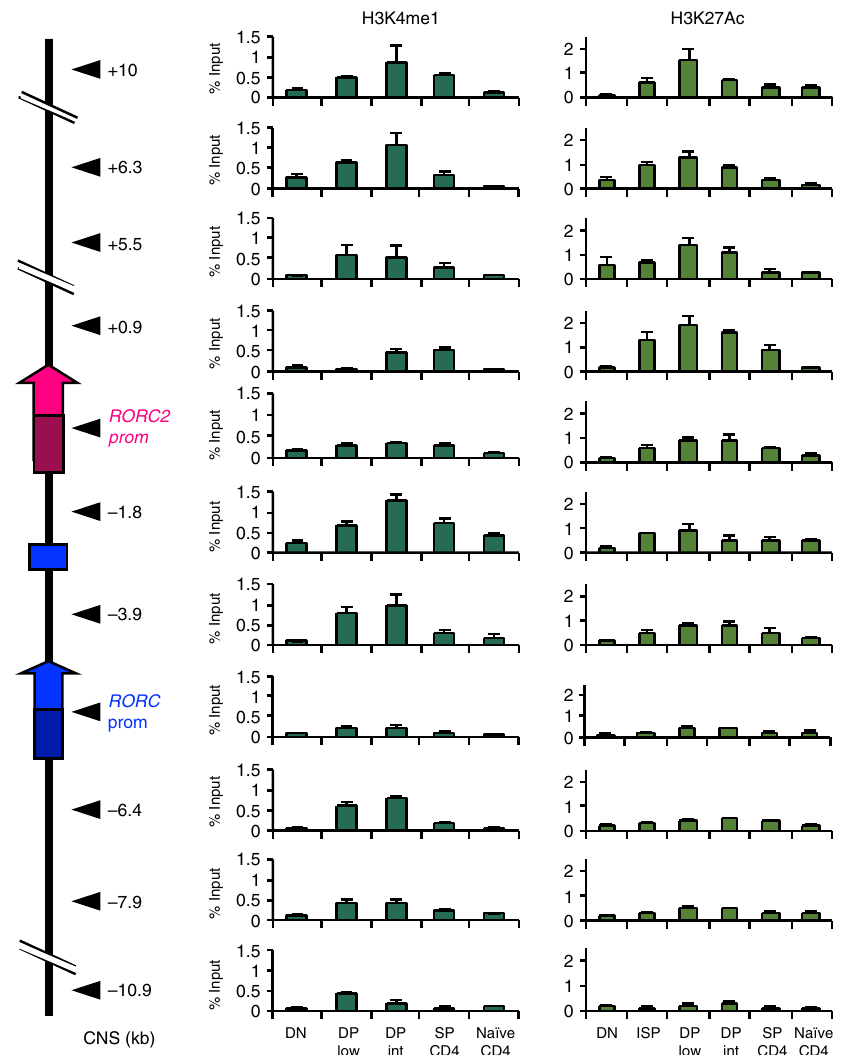
Fig. 3 Enrichment of enhancer marks at the RORC locus in thymocytes. Enrichment of H3K4me1 (left panels) and H3K27Ac (right panels) was analyzed in different thymocyte populations, and in naive CD4 + T cells. Data represent average and SD of three replicates. The diagram on the left shows the regions analyzed, de fi ned by their distance from RORC2 TSS. Source data are provided as a Source Data fi